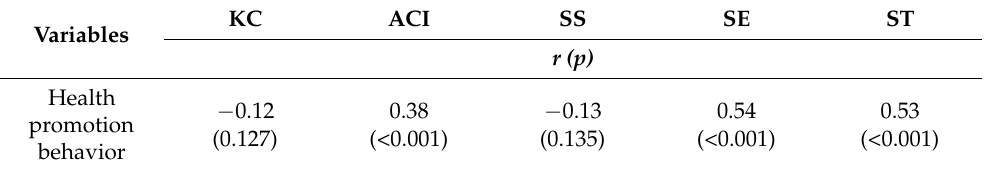
Table 3. Correlations Between Health Promotion Score and each of the Study